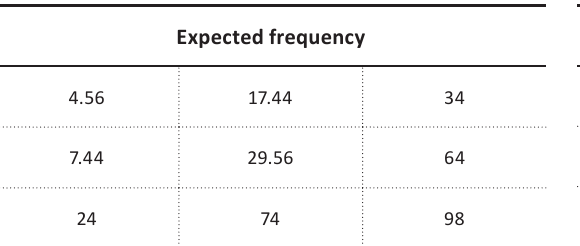
Source: Own survey.